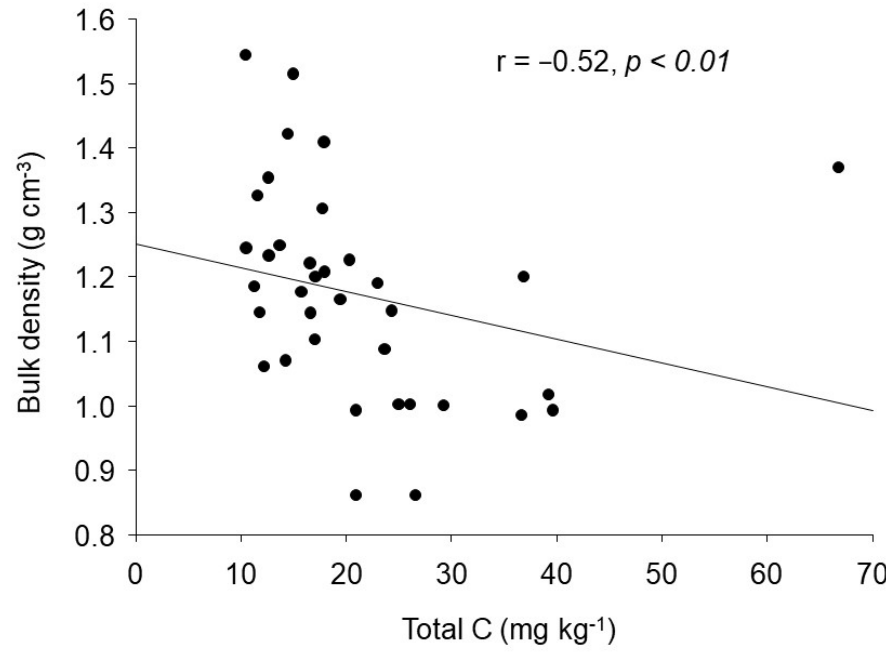
Figure 5. Spearman correlation between bulk density and SOC for Dompem soils.